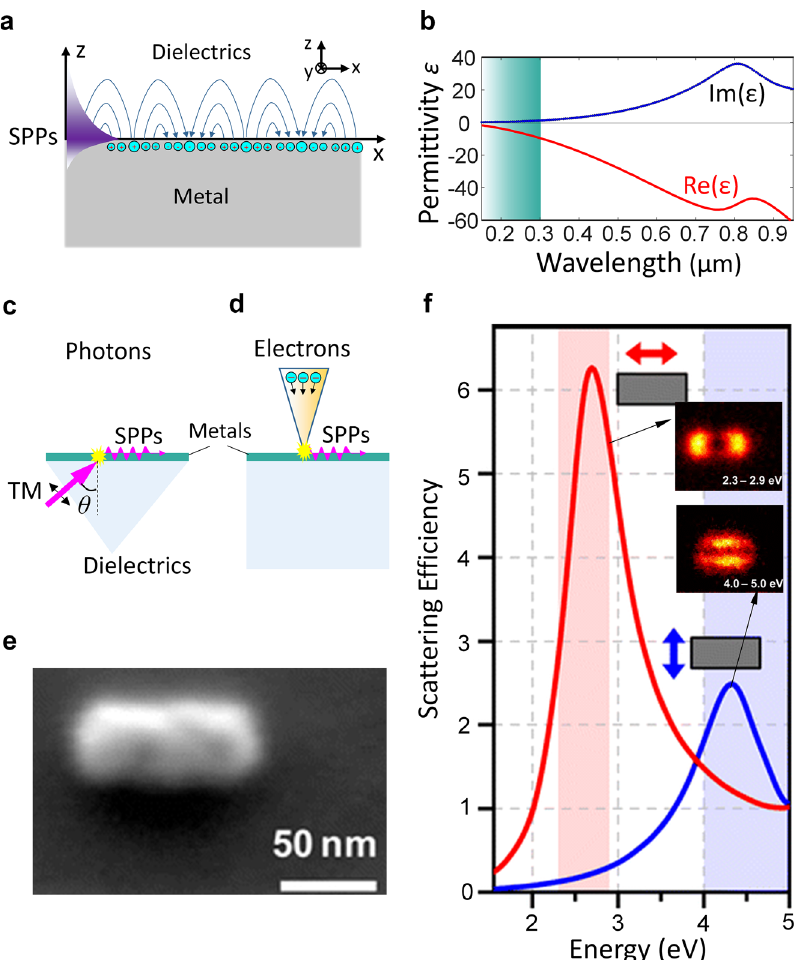
Figure2: (a)Sketchof SPPsat theinterfacebetweendielectricandmetal.(b)Permittivityofaluminum.(candd)Sketchoftheexcitationof UV SPPs byusingphotons (c) andelectrons (d).(e)SEM image of an aluminum nanorod. (f) The simulated scattering intensity for the longitudinal (red) and transverse (blue) plasmonic modes existing in the aluminum nanorod in (e). Knight et al. [38]. © 2012 American Chemical Society. The inserts show the experimental measured plasmonics modes with different photon